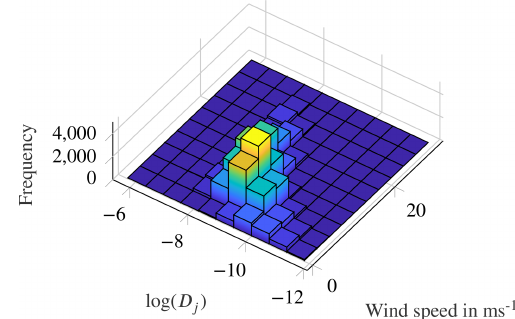
Figure 8. Correlation of wind speeds and logarithmised short-term damage values ( D j ) determined using the strain gauge at 315 ◦ . His- togram based on all 10min intervals in 2016.